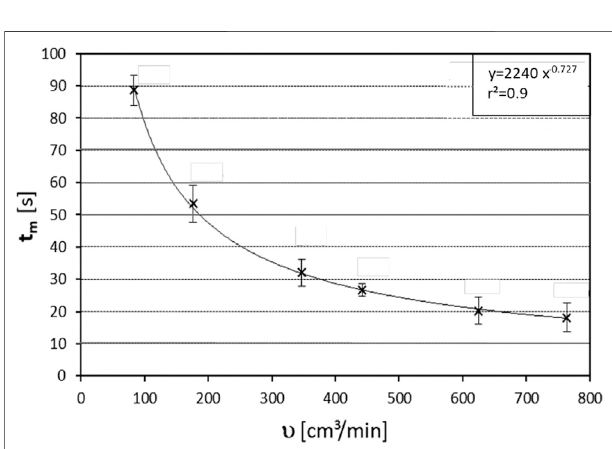
FIGURE 7 | Relationship between the volume fl ow ( υ [cm³/min]) and the mean residence time (tm [s]) quanti fi ed by the SGD-MRT. The comparison is considered an independentvalidation of the mean residence time suitability to quantify volume fl